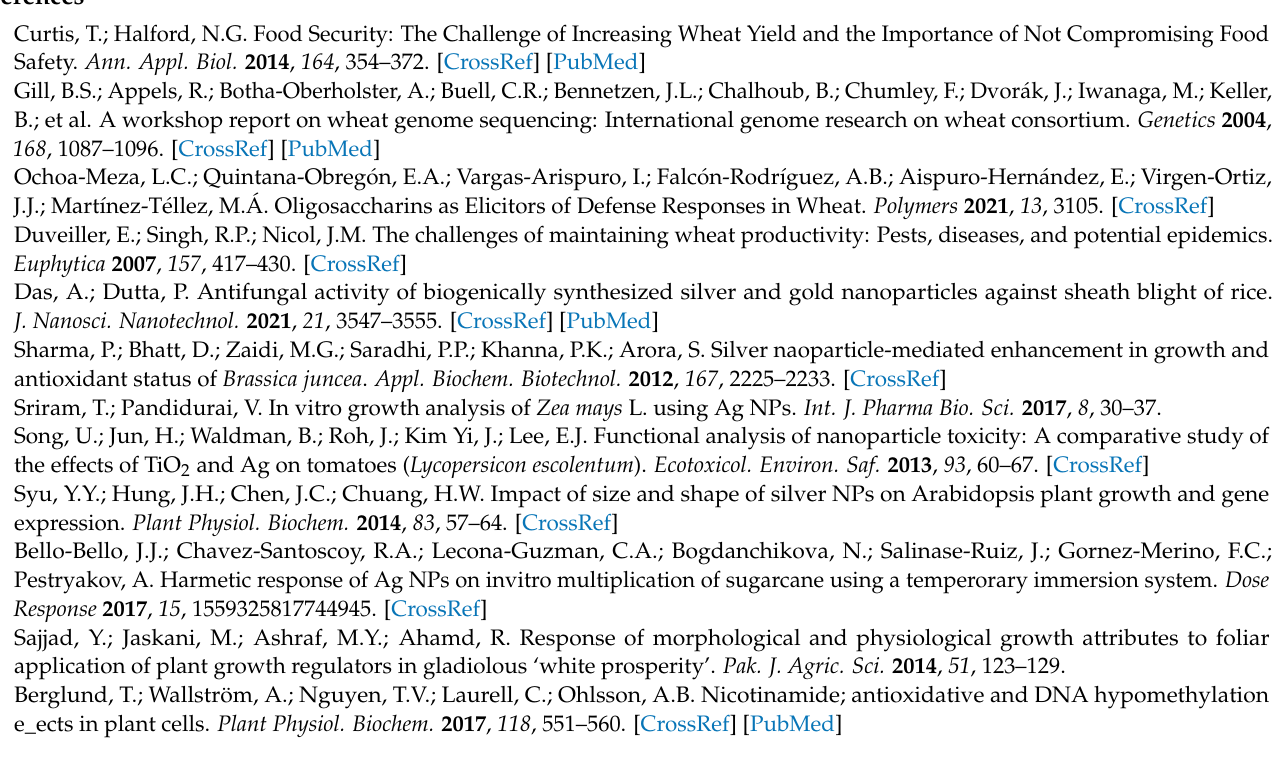
Figure S1: Venn diagram of proteomics results and overview of total proteomic data from six samples of wheat root based on PCA; Figure S2: Blots of the entire membrane with anti-ascorbate peroxidase, glutathione reductase, and peroxiredoxin antibodies, which were used in Figure 4 Leaf; Figure S3: Blots of the entire membrane with anti-ascorbate peroxidase, glutathione reductase, and peroxiredoxin antibodies, which were used in Figure 4 Root; Figure S4: Blots of the entire membrane with anti-PR1, PR3, and PR5, which were used in Figure 5 Leaf; Figure S5: Blots of the entire membrane with anti-PR1, PR3, and PR5, which were used in Figure 5